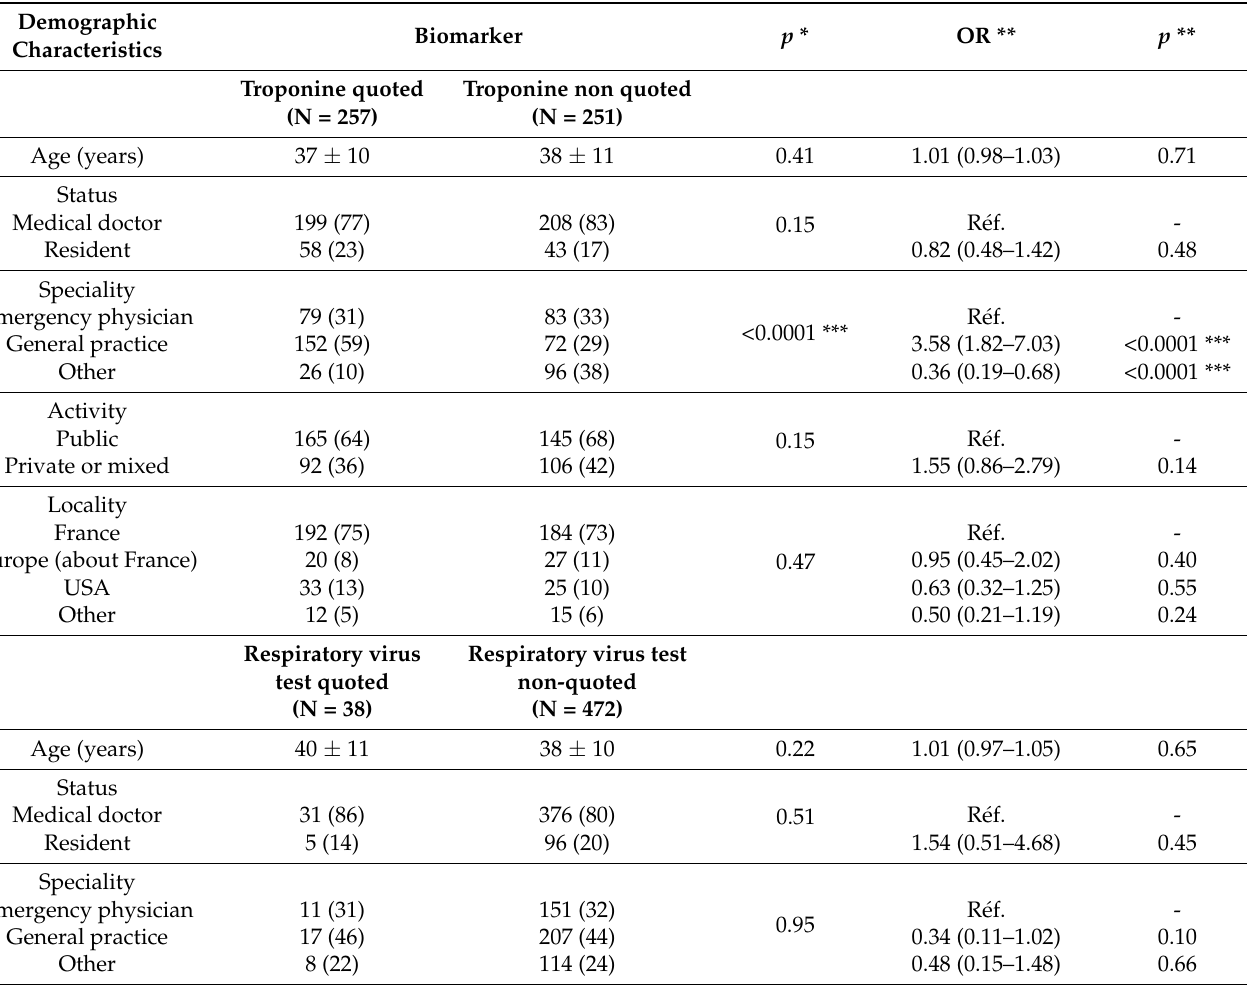
Table A3. Interest biomarkers and medical